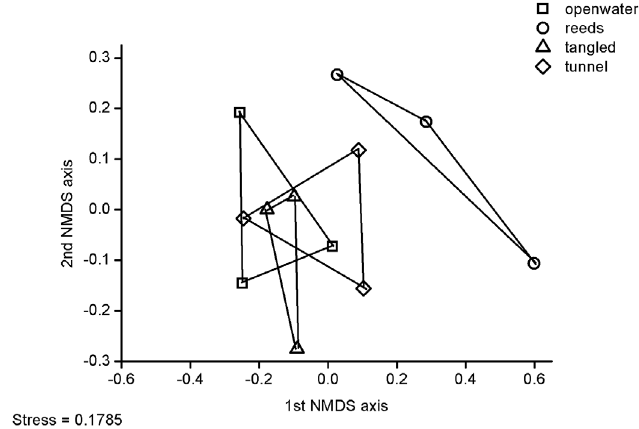
Figure 3. NMDS ordination of the benthic Cladocera remains of vegetation types